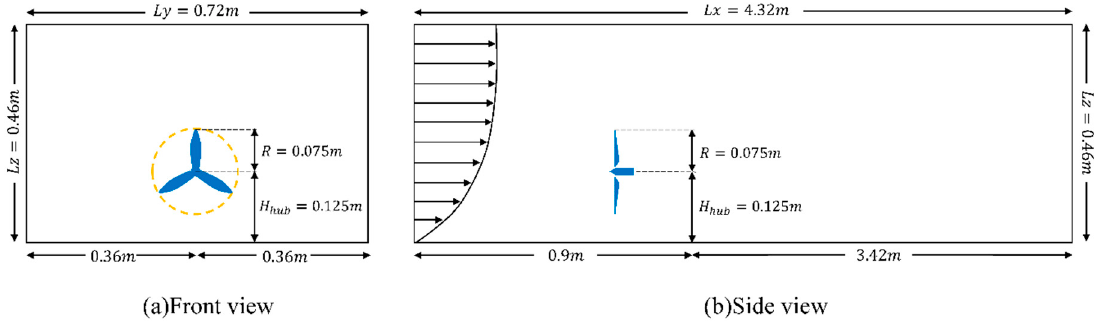
Figure 4. Scheme of the computational domain, ( a ) front view; ( b ) side view.